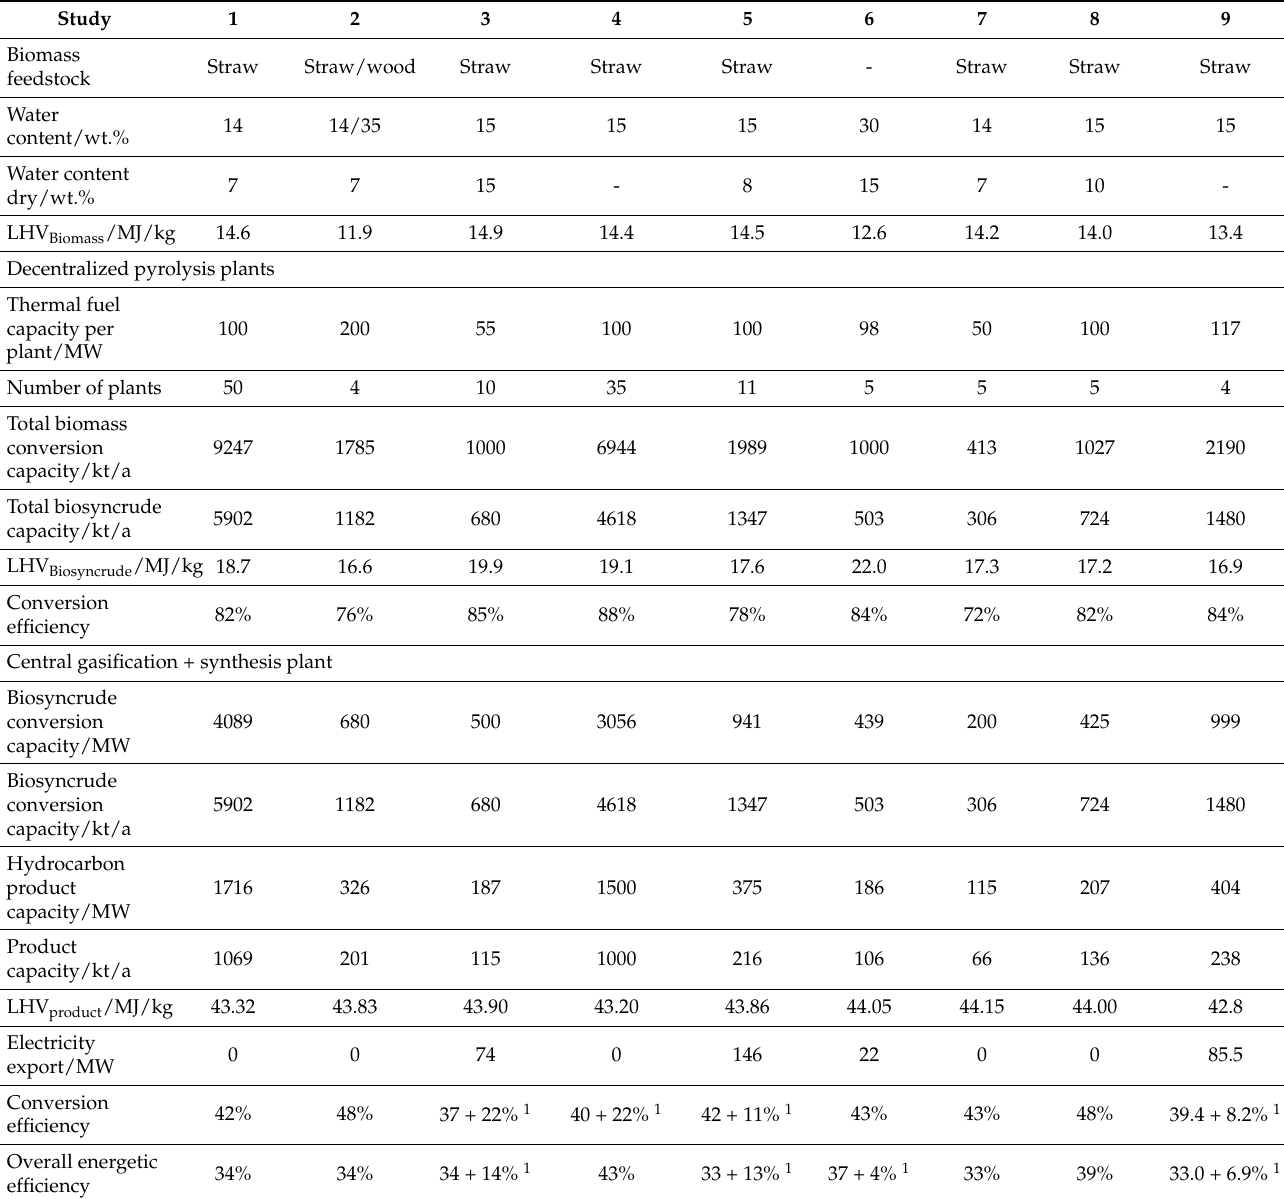
Table 3. Overview of feedstock and process characteristics of the investigated